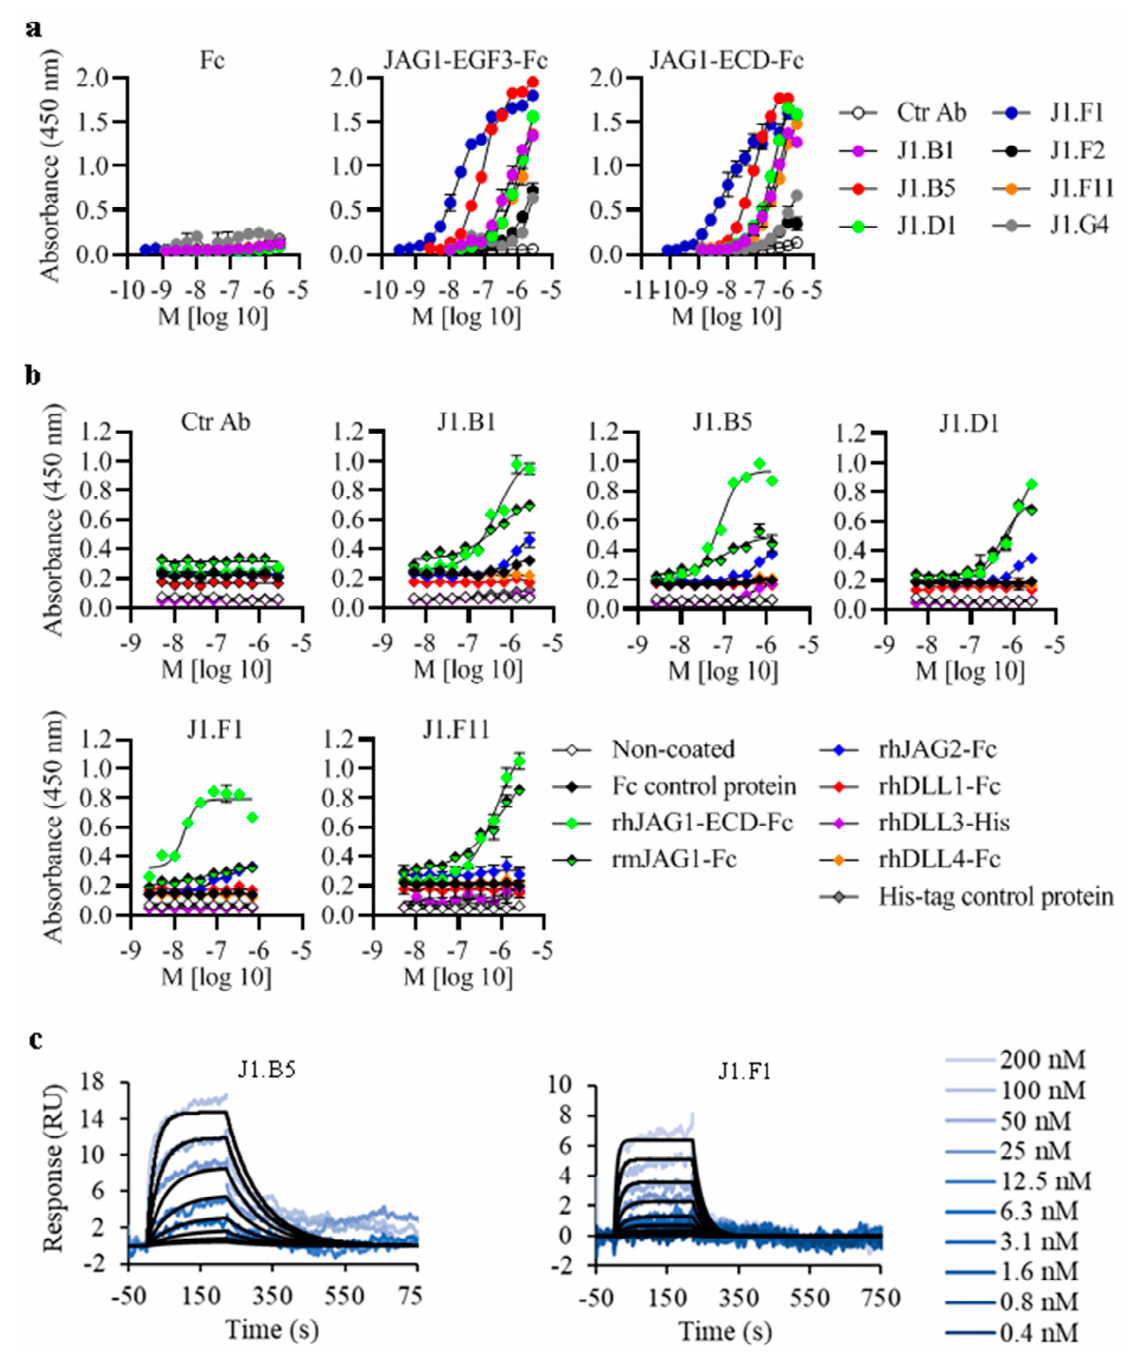
Figure 1. Anti-JAG1 Abs binding ability, specificity, and affinity for recombinant human (rh) JAG1 proteins. ( a ) Ability of anti-JAG1 Abs to recognize rhJAG1 proteins. rhJAG1-EGF3-Fc (with ECD up to the EGF3 domain), rhJAG1-ECD-Fc (with complete ECD), and Fc (negative control) protein were immobilized in 96-well plates (5 µ g/mL in PBS, 16 h, and 4 ◦ C) and incubated with serial dilutions of anti-JAG1 Abs or isotype-matched negative control Ab (Ctr Ab) (starting from 200 µ g/mL). Binding was evaluated with ELISA. ( b ) Binding specificity of anti-JAG1 Abs. Abs binding to rhJAG1-Fc proteins was tested for binding to other human Notch ligands (rhDLL1, rhDLL3, rhDLL4, and rhJAG2) and murine JAG1 (rmJAG1) as in ( a ). Noncoated wells and wells coated with Fc or with an irrelevant His 6 -tagged protein were used as negative controls. Graphs in ( a ) and ( b ) are representative of three independent assays each performed in duplicate. ( c ) SPR sensorgrams of rhJAG1–ECD–Fc interactions with the lead anti-JAG1 Abs J1.B5 and J1.F1. Representative curves from one assay run with three technical replicates are shown.